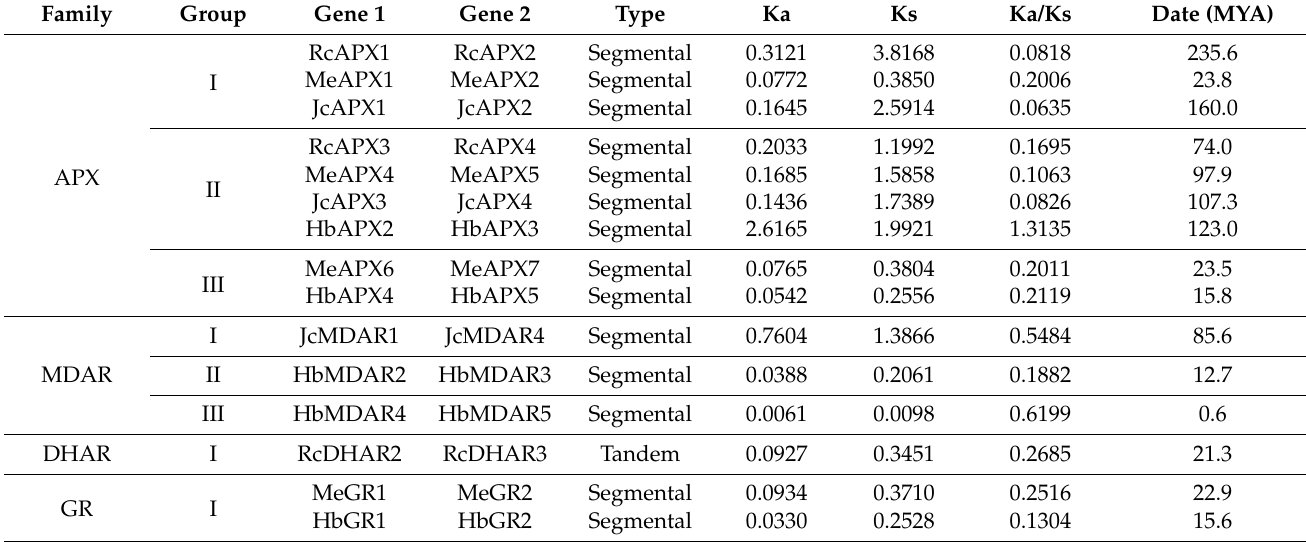
Table 2. Ka/Ks analysis and divergence time between the duplicated APX, MDAR, DHAR, and GR gene pairs in Ricinus communis (Rc), Manihot esculenta (Me), Jatropha curcas (Jc) and Hevea brasiliensis (Hb). Ka. Non-synonymous substitution rate; Ks. Synonymous substitution rate; MYA. Million years